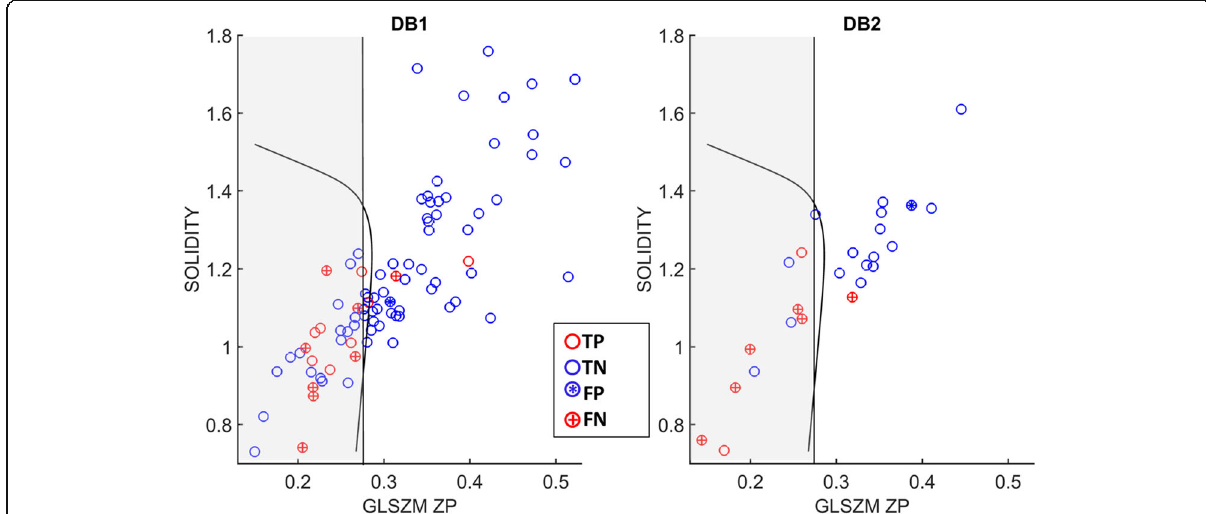
Fig. 5 Results of LN visual detection and radiomic analysis are represented together on DB1 (left panel) and DB2 (right panel). For each patient, GLSZM ZP and SOLIDITY values are shown. Blue circles correspond to patients with histologically negative lymph nodes, while red circles to patients with histologically positive lymph nodes. Patients with a ‘ + ’ in the red circle and with a ‘ * ’ in the blue circle are those which are misclassified by the LN visual detection: in particular, blue circles containing a ‘ * ’ are false positives at LN visual detection, while red circles containing a ‘ + ’ are false negatives. The grey area contains patients classified as positive by the univariate radiomic analysis (GLSZM ZP < 0.2755); therefore false positives are blue circles in the grey area, while false negatives are red circles in the white area. The curve line is an example of neural network trained on the 86 DB1